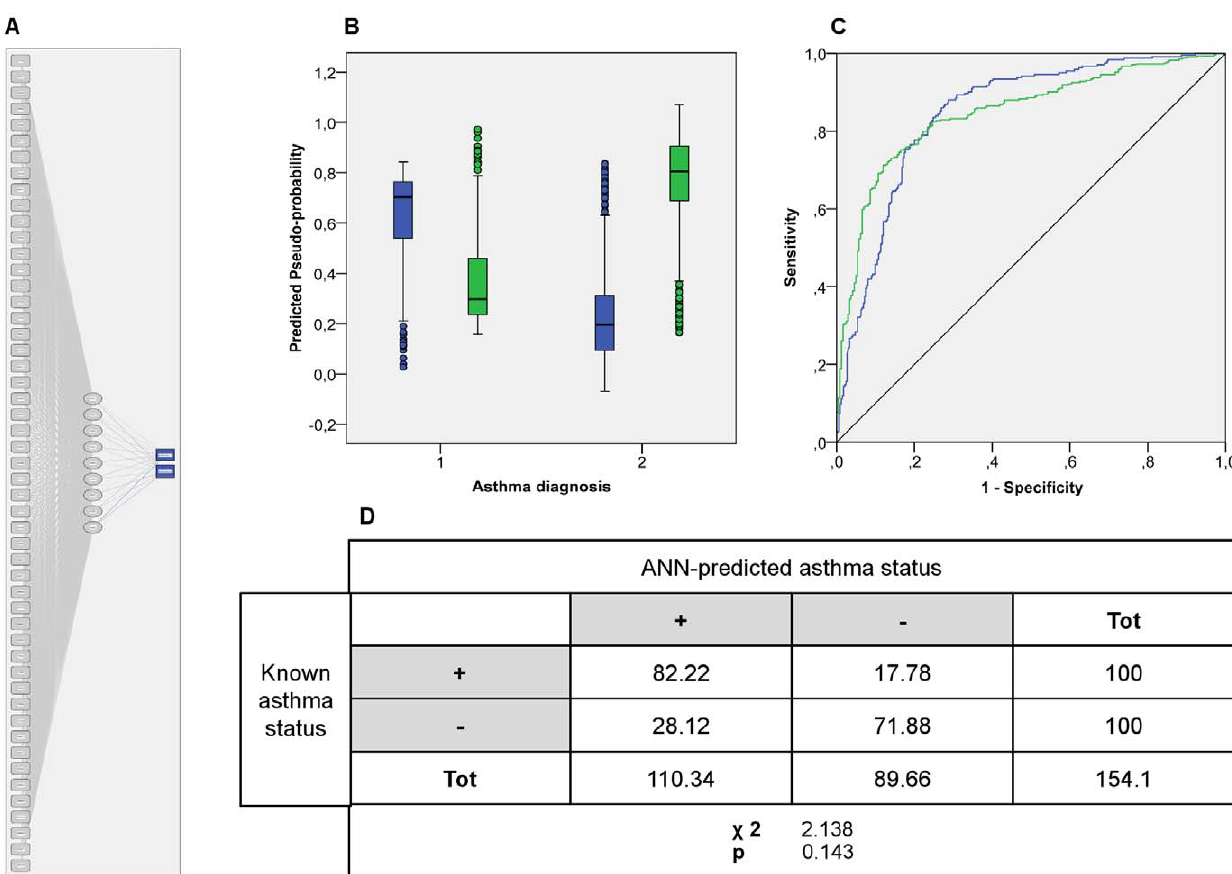
Figure 3. Architecture and performance of the RBF based ANN asthma classifier. (A) ANN architecture. The RBF network consists of three layers: Input (boxes 1–51), hidden (circles 1–8) and output (asthma classes in blue boxes) layer respectively. (B) ANN predicted-by-observed performance chart. The box plots represent the predicted-pseudo-probabilities for the RBF output category; non-asthmatic (green) and asthma (blue) plotted against the known clinical status non-asthmatic (1) asthmatic (2) for combined training and testing samples. (C) The ROC curve calculated on the combined training and testing samples. (D) ANN asthma classifier consistency performance. The ANN-predicted asthma status of the hold out samples was assessed on a Pearson’s X 2 test against the known clinical status of the selected individuals.